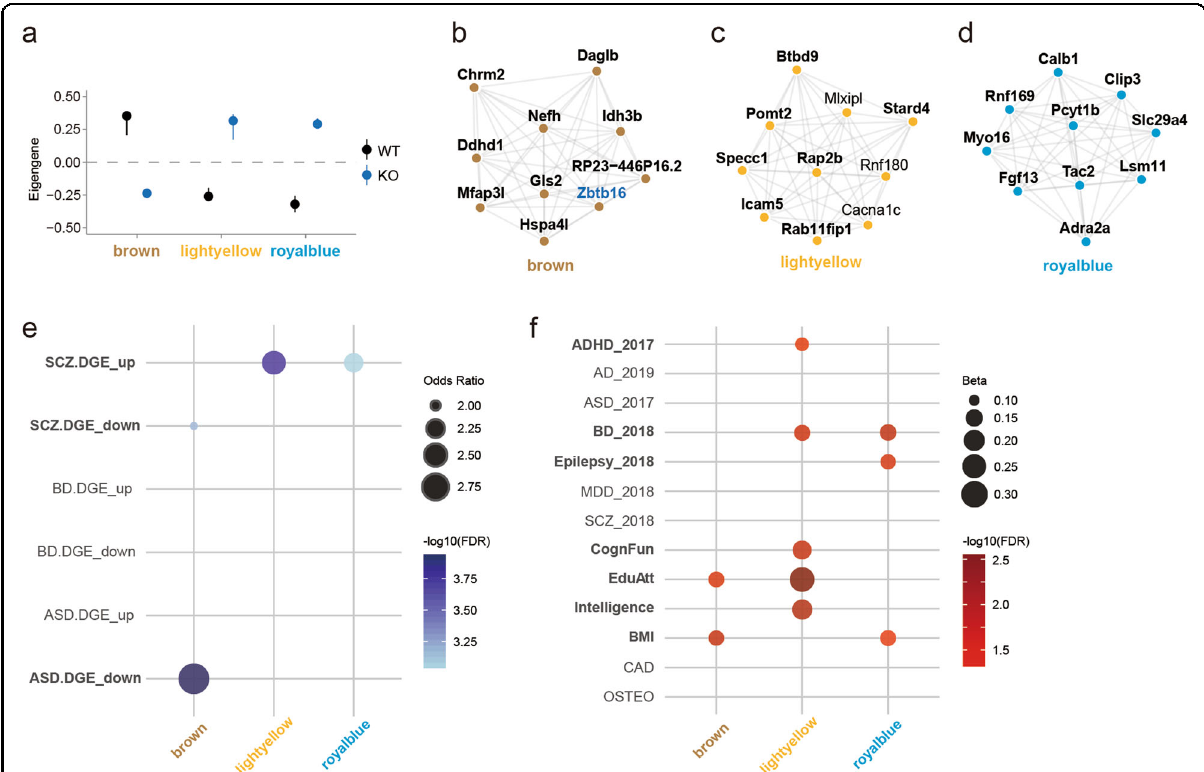
Fig. 5 Co-expressed gene networks uncovered gene networks unique to ASD and SCZ. a Dot plots with standard errors (SEs) showing module eigengene demonstrate the association of the modules detected by parsimony for Zbtb16 . Y -axis = rho, X -axis shows the modules highlighted. b – d Zbtb16 -speci fi c modules showing the top 10 hub genes ranked by weighted topological overlap values in the brown ( b ), light yellow ( c ), and royal blue ( d ) modules. Zbtb16 DEGs are shown in boldface. e Zbtb16 -speci fi c modules showing the enrichment for disorder-speci fi c human transcriptome. The brown module is enriched for ASD and schizophrenia downregulated genes. The light yellow and royal blue modules are enriched in schizophrenia upregulated genes. SCZ: schizophrenia, BD: bipolar disorder, ASD: autism spectrum disorder. f Zbtb16 -speci fi c modules are associated with BMI, cognitive traits, ADHD, BD, and epilepsy. Dot plots represent Betas from MAGMA. Dot colors represent the − log10(FDR) from MAGMA. Y -axis shows the acronyms for the GWAS data utilized for this analysis (see Methods). The X -axis shows the modules of this study.